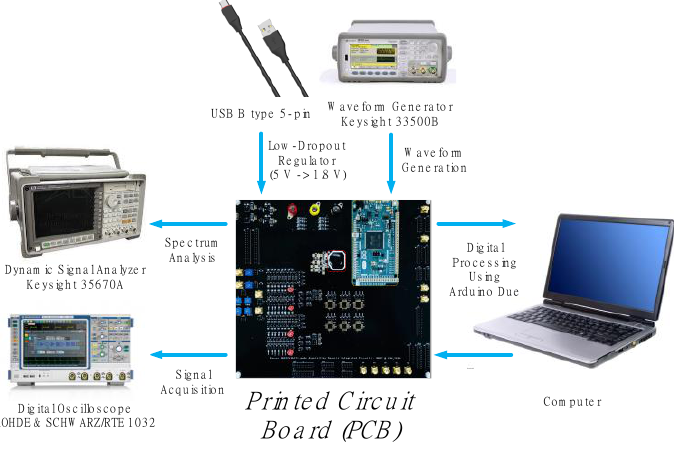
Figure 8. Measurement setup for the proposed readout circuit.